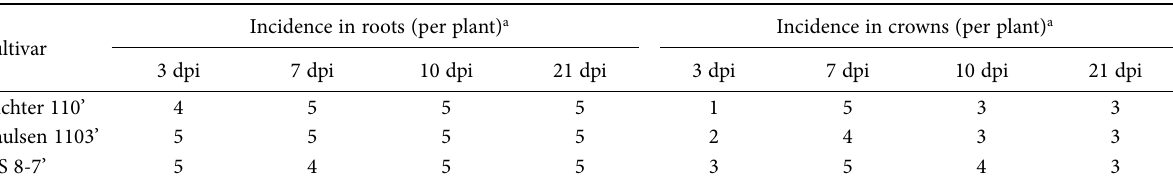
Table 2. Numbers of plants from which Trichoderma atroviride T-77:: tdTomato were re-isolated from roots and crowns after 3, 7, 10 or 21 d post-inoculation (dpi).